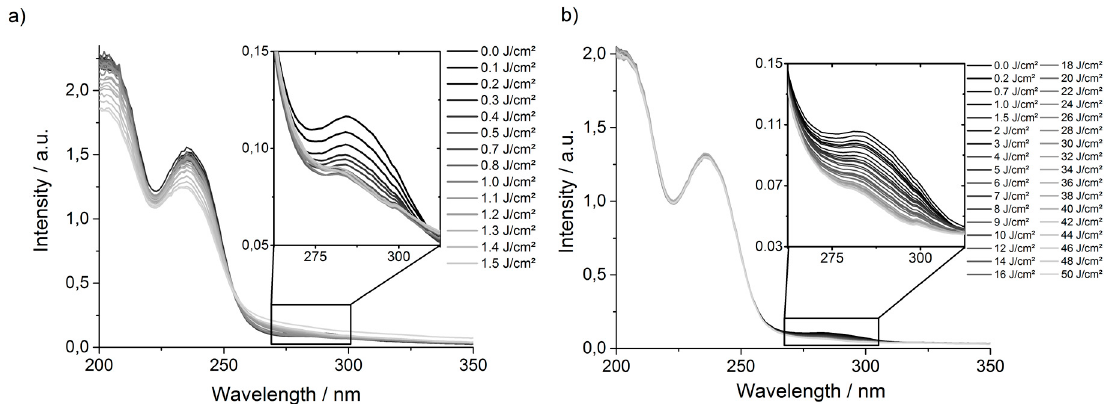
Figure 3. UV absorption spectra of P(4 95 -BP 5 ) films irradiated at ( a ) λ = 254 nm with 0 to 1.5 J · cm − 2 and ( b ) λ = 365 nm with 0 to 50 J · cm − 2 . The insets show the reduction of the adsorption band of the benzophenone moieties as a function of the irradiation energy.